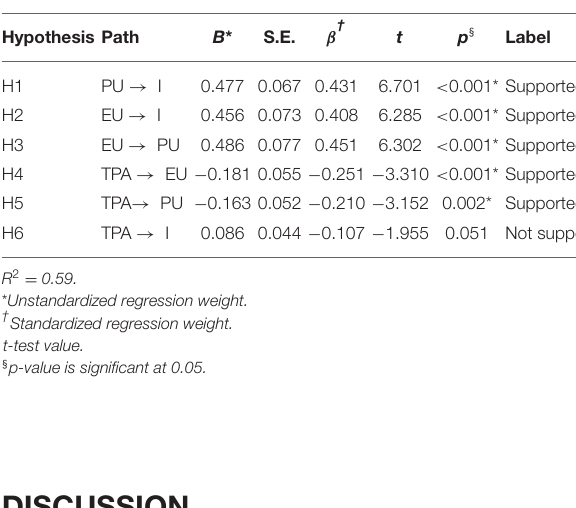
TABLE 3 | Correlation Matrix and Square Root of the AVE.